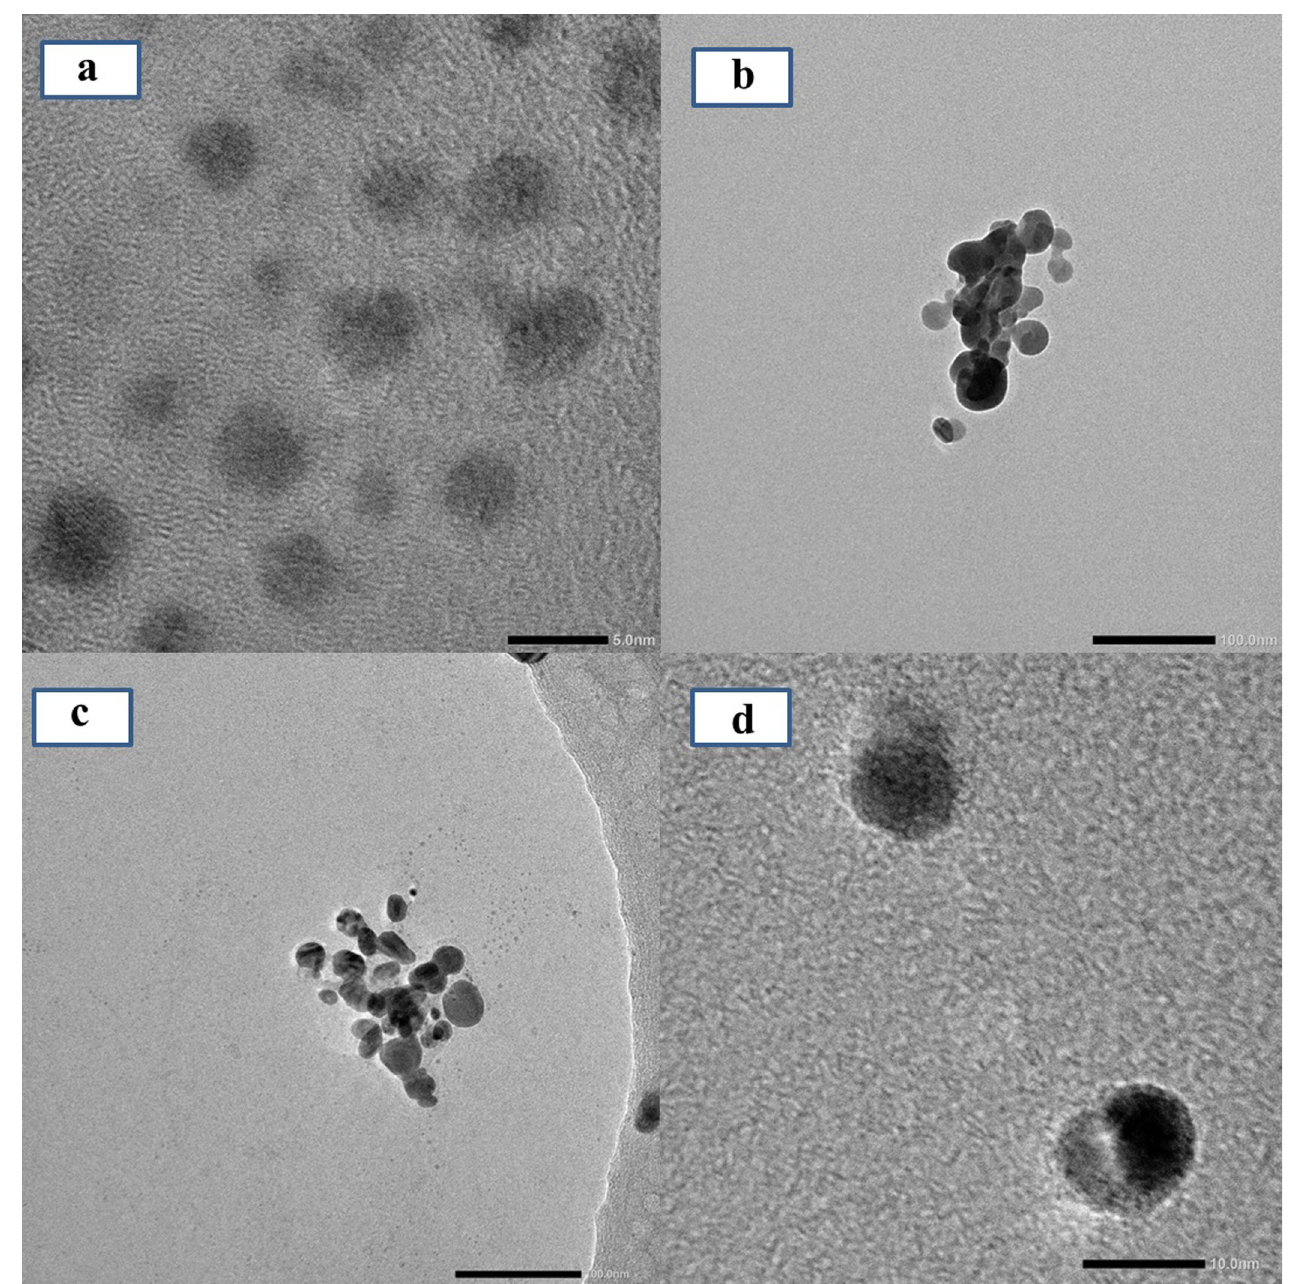
Fig 3. TEM images of the synthesized Z . officinale AgNPs under different magnifications: (a) AgNPs (synthesized using water extract of fresh ginger peel) at 5 nm; (b) AgNPs (synthesized using ethanol extract of fresh unpeeled ginger) at 100 nm; (c) AgNPs (synthesized using water extract of dry unpeeled ginger) at 100 nm; (d) AgNPs (synthesized using ethanol extract of dry ginger peel) at 10